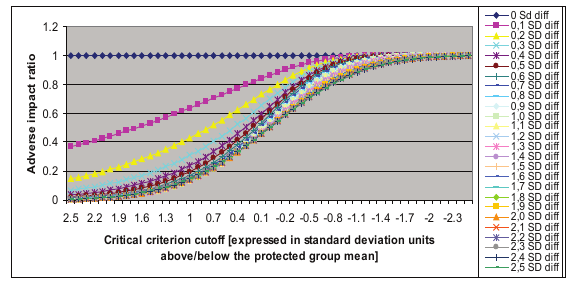
FIGURE 2 Adverse impact ratio as a function of the criterion cut-off in the protected group predicted criterion distribution and the difference in the mean predicted criterion performance: expressed in standard deviation units